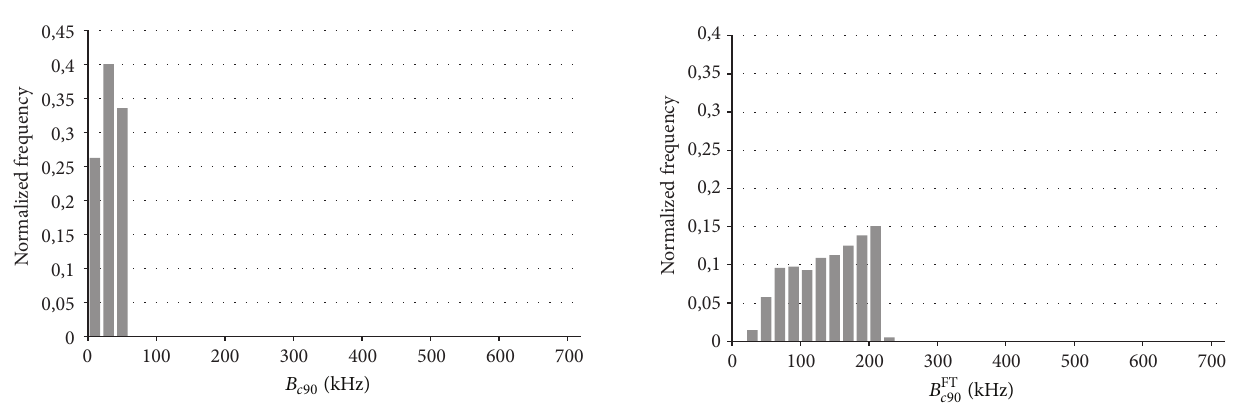
Figure 14: Histogram of coherence bandwidth values estimated from Fourier transform of PDP for correlation level 0.9 in the Gdansk city